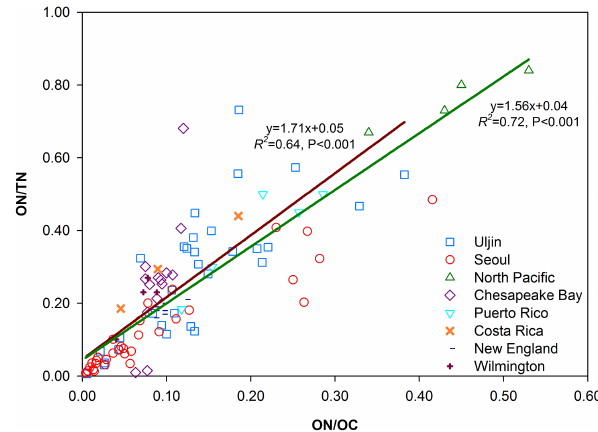
Figure 6. Plot of ON / TN versus ON / OC in precipitation samples collected at Uljin ( N = 33) and Seoul ( N = 33) in Korea and other locations worldwide, including the western North Pacific (aerosols, N = 4), Chesapeake Bay ( N = 14), Puerto Rico ( N = 5), Costa Rica ( N = 3), New England ( N = 15), and Wilmington ( N = 4). The solid lines denote the best-fit correlations for Uljin data (red) and the entire data set